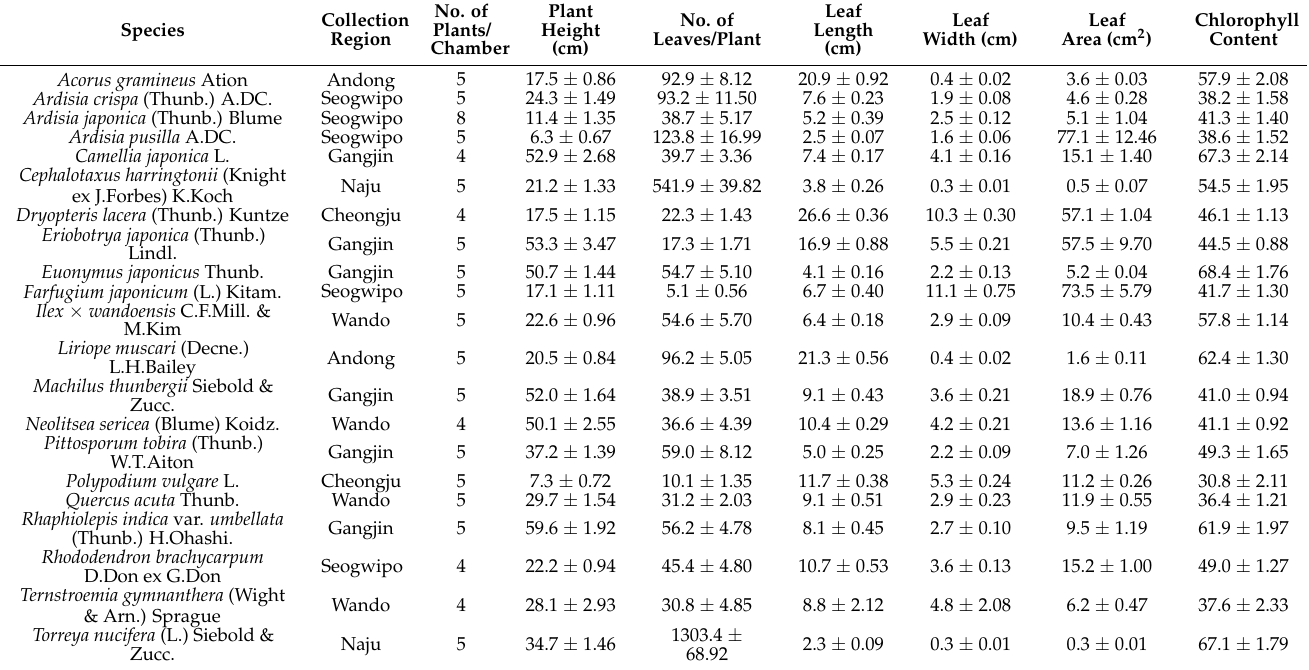
Table 1. Plant information and growth parameters of 21 species indigenous to